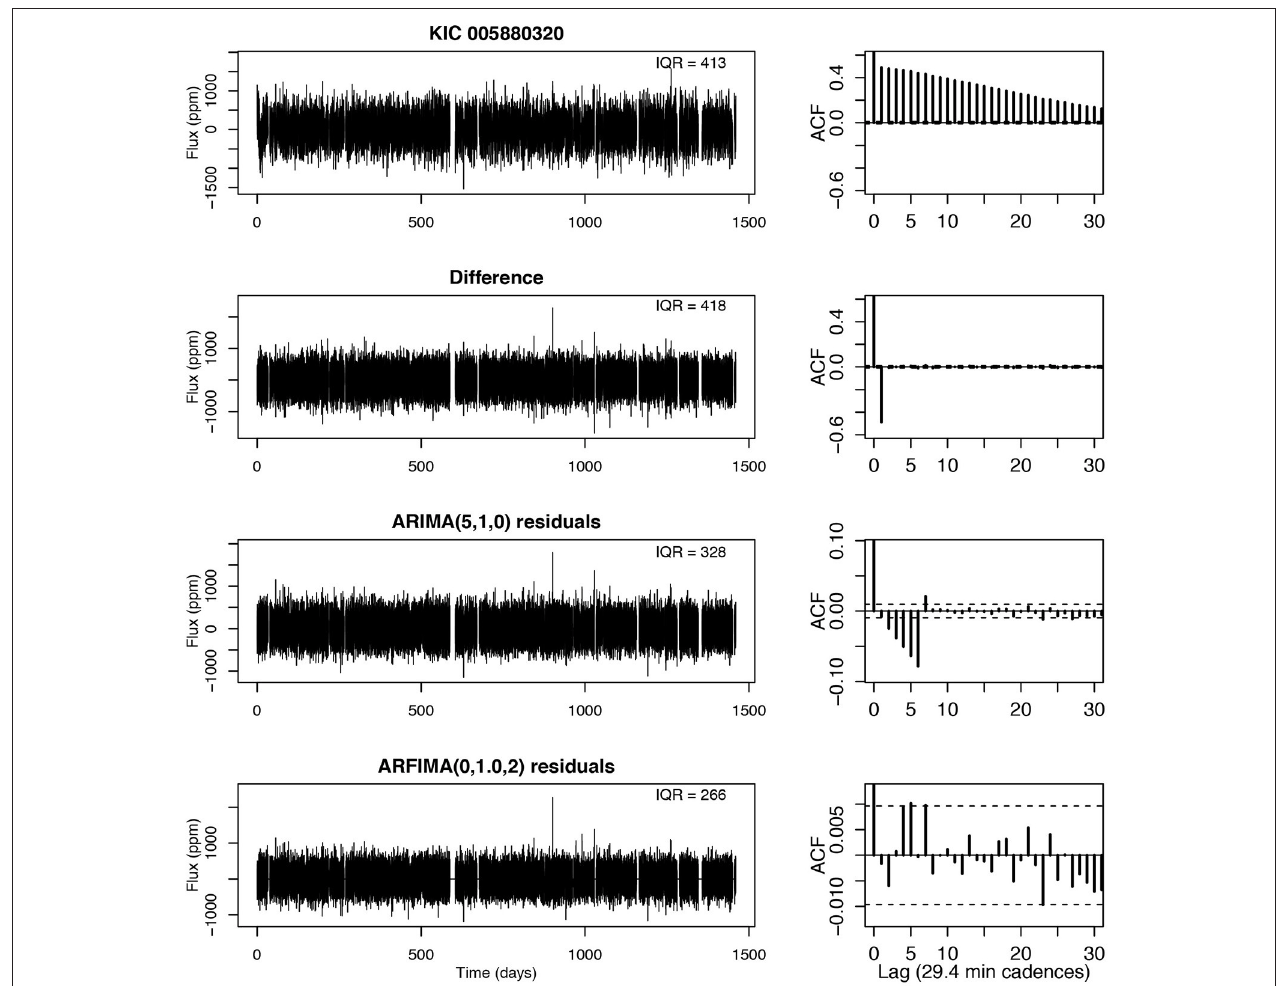
FIGURE 1 | Space-based Kepler mission photometric light curve of a quiet star with autoregressive modeling. Left panels from top to bottom: Original light curve; differenced light curve; ARIMA model residuals; ARFIMA model residuals. Right panels show the autocorrelation function at each